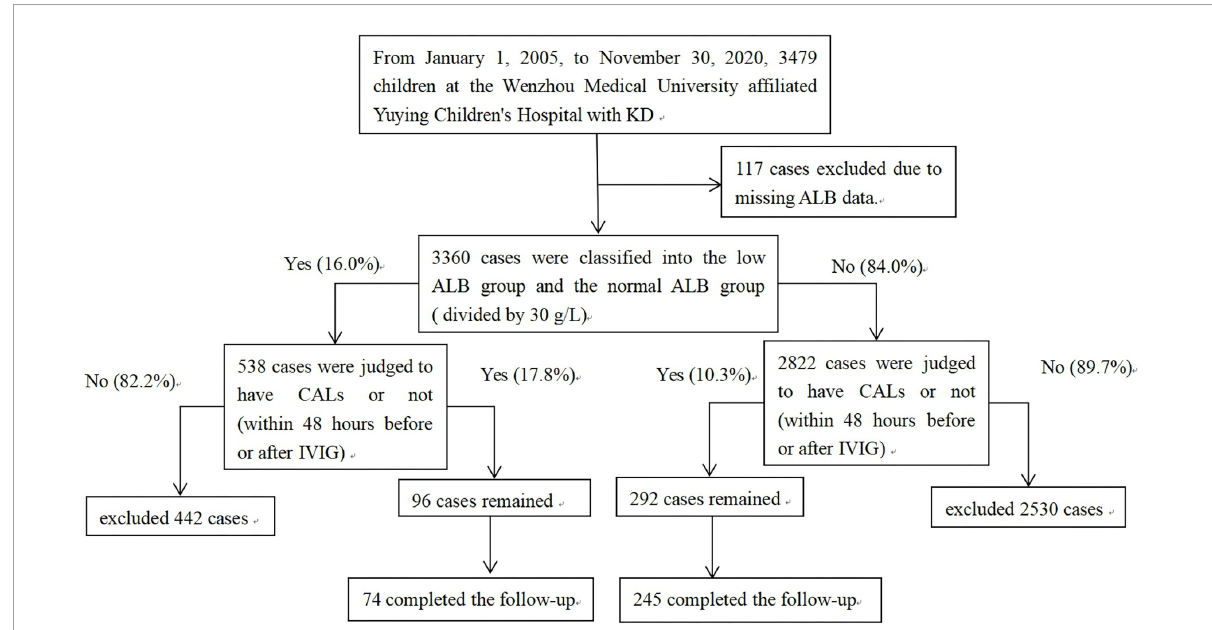
FIGURE1 Patients flow chart. Flow chart showing the demographic and clinical information of all study participants. From 1 January 2005 to 30 November 2020, 3,479 children in our KD database were enrolled. A total of 117 cases were excluded due to missing ALB data. The remaining patients were classified into the low ALB group and the normal ALB group, divided by 30 g/L. A total of 319 patients who had CALs within 48 h before or after IVIG treatment and rechecked the echocardiography at 1 month after KD onset were included in the final analysis. KD, Kawasaki disease; CALs, coronary artery lesions; IVIG, intravenous immunoglobulin; ALB, albumin